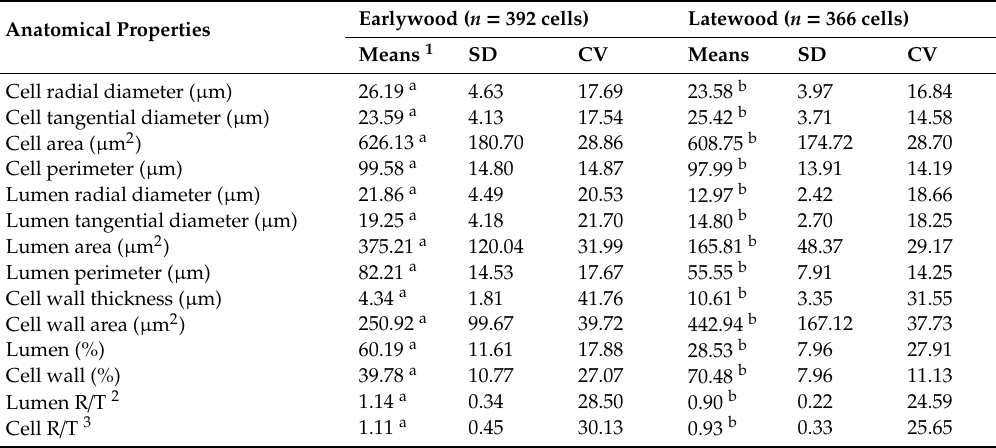
Table 1. Means and variations (standard deviation (SD) and coe ffi cient of variance (CV)) in anatomical properties in early- and latewood T. occidentalis